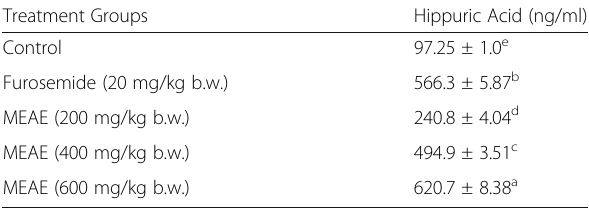
Table 2 Effect of MEAE on hippuric acid concentration in urine samples collected from MEAE treated rats Treatment